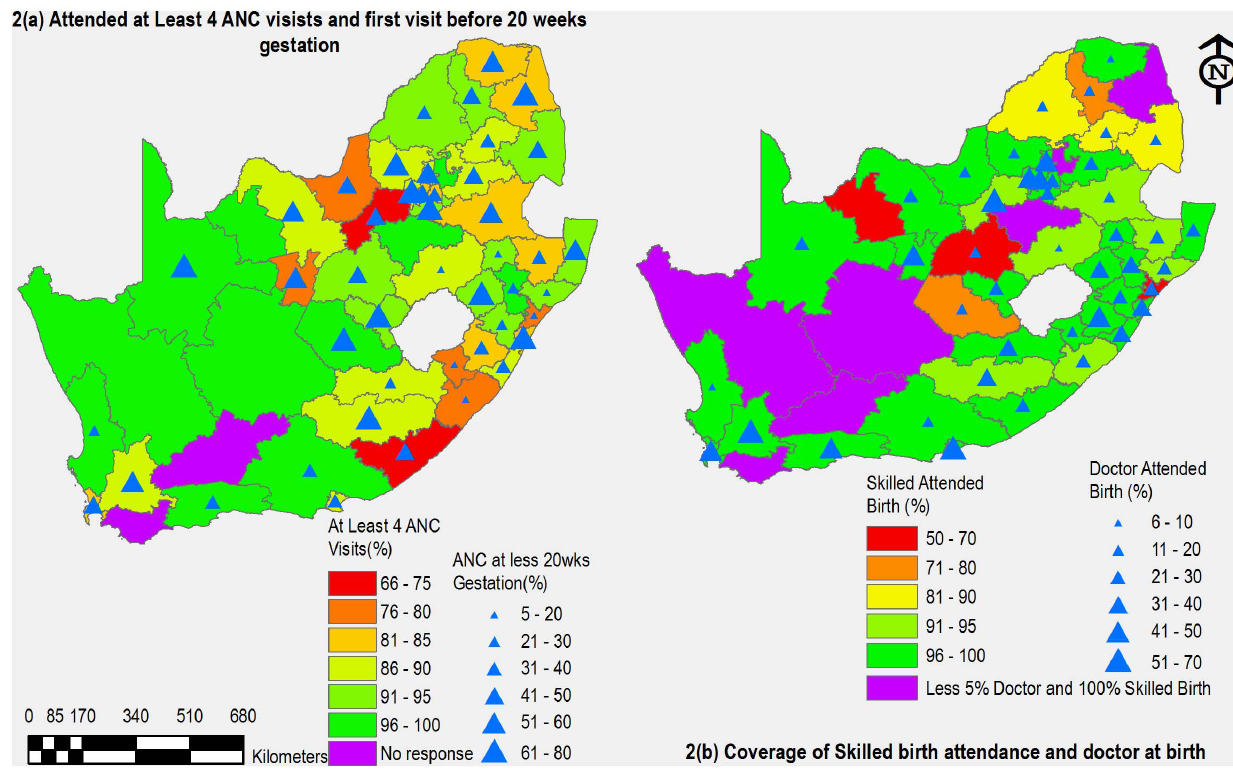
Figure 2. Utilzation of antenatal clinic services and skilled birth attendance in South Africa. Utilzation of antenatal clinic services and skilled birth attendance, by district in South Africa, findings of national survey.